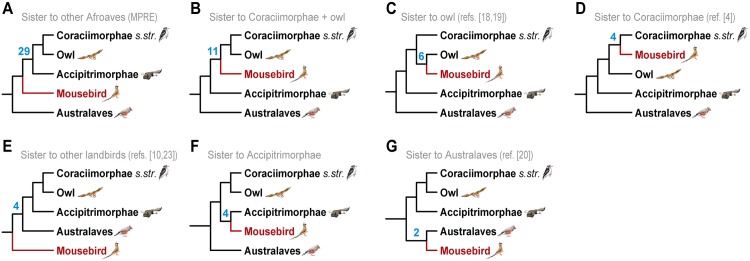
Comparison of RE marker support for the possible positions of mousebirds within core landbirds.The seven alternative groupings are shown in descending order of support and include the mousebird topology of (A), our MPRE tree and the genome-level UCE tree of [4], (C) the Hackett et al. tree [18], (D) the main Jarvis et al. tree [4], (E) two limited retrotransposon studies [10,23], and (G) the main McCormack et al. tree [20]. Blue bold numbers indicate the amount of RE insertion events that are conflict-free with each of the seven alternatives, respectively. Higher-level taxon names are shown for well-supported monophyla, such as the eagles/New World vulture clade (Accipitrimorphae [4]), the passerine/parrot/falcon/seriema clade (Australaves [25]), and the woodpecker/bee-eater/hornbill/trogon/cuckoo-roller clade (Coraciimorphae [4], sensu stricto without mousebird). The bird paintings were generated by Jon Fjeldså (used with permission).